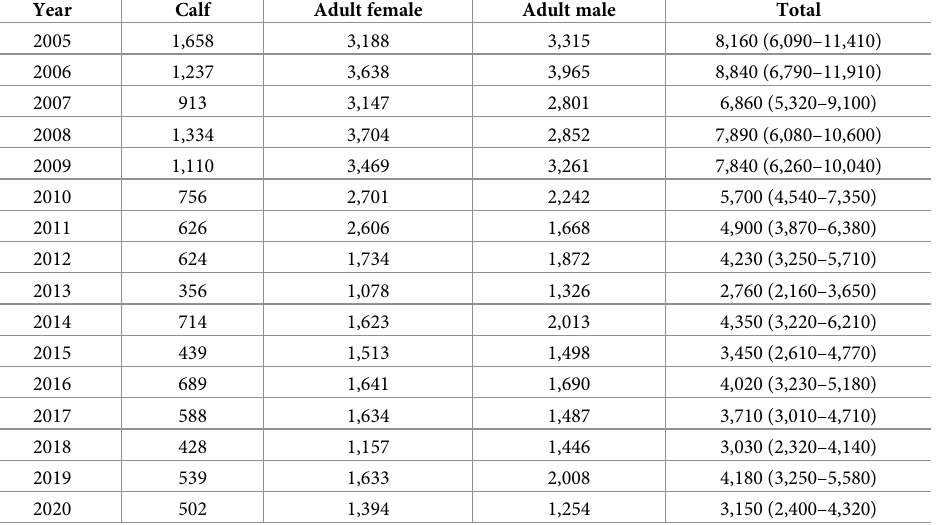
Table 1. Moose population estimates by year, sex, and age class. Age-class-specific aerial survey data with corre- sponding annual totals and 90% confidence intervals for moose in northeastern Minnesota, USA, 2005–2020 [9]. Total abundance is corrected for sightability, abundance of calves, adult females, and adult males is derived from reported calf:adult female and adult male:adult female